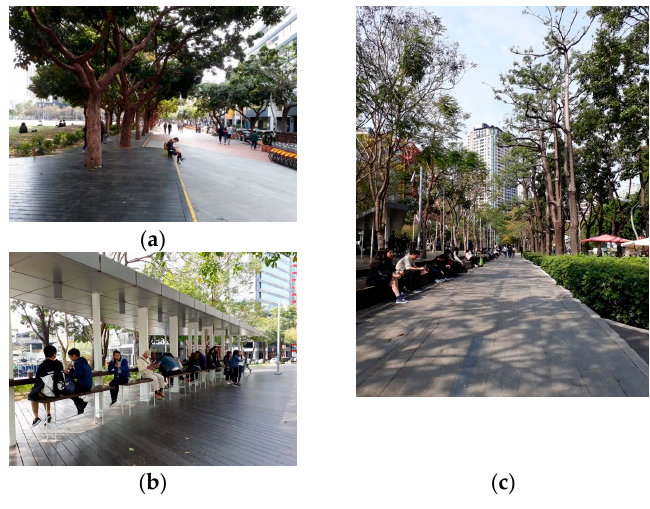
Figure 3. Major squares and entrances of the Taichung Calligraphy Greenway.